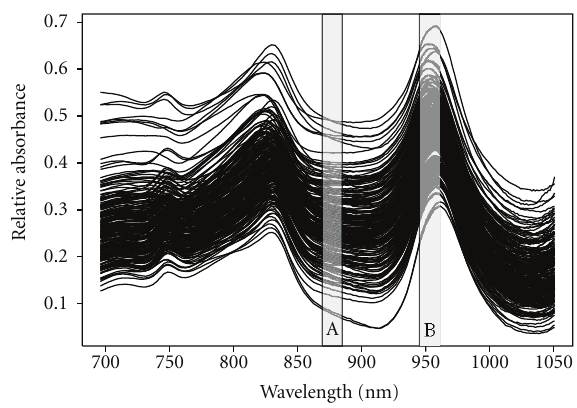
Figure 1: Raw data from 227 NIR spectral profiles of AF samples plotted relative to air. The boxes labeled A and B show the regions selected by a genetic algorithm, which give the best separation of term and preterm groups.